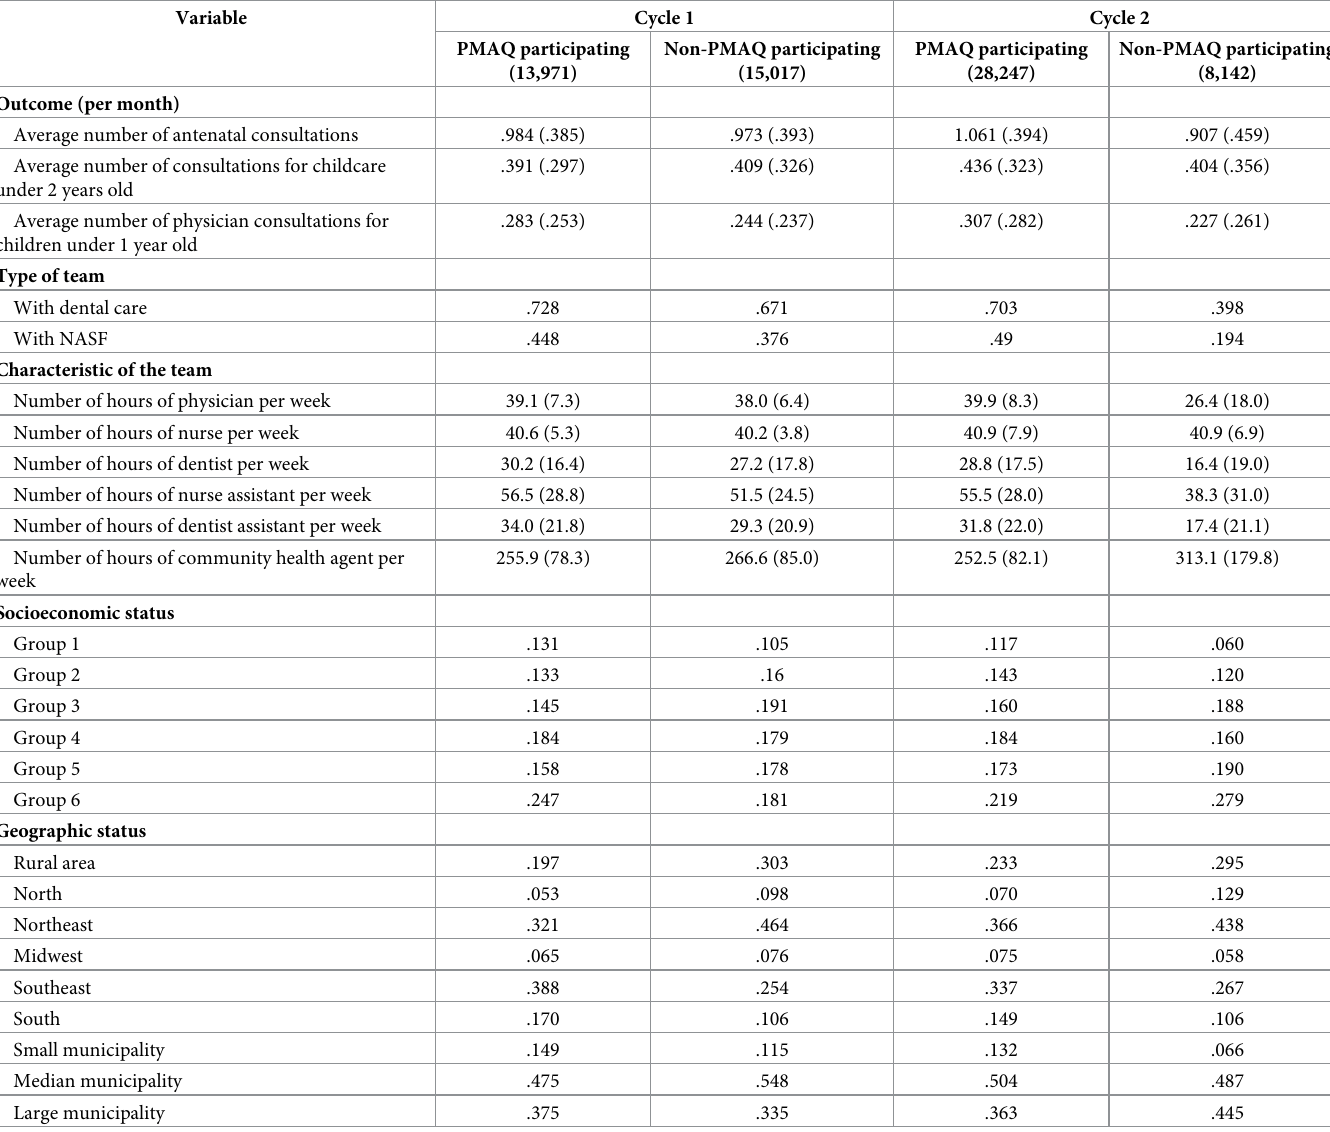
Table 1. Descriptive statistics of the variables used in the model, stratified by participation in PMAQ and cycles, Brazil,